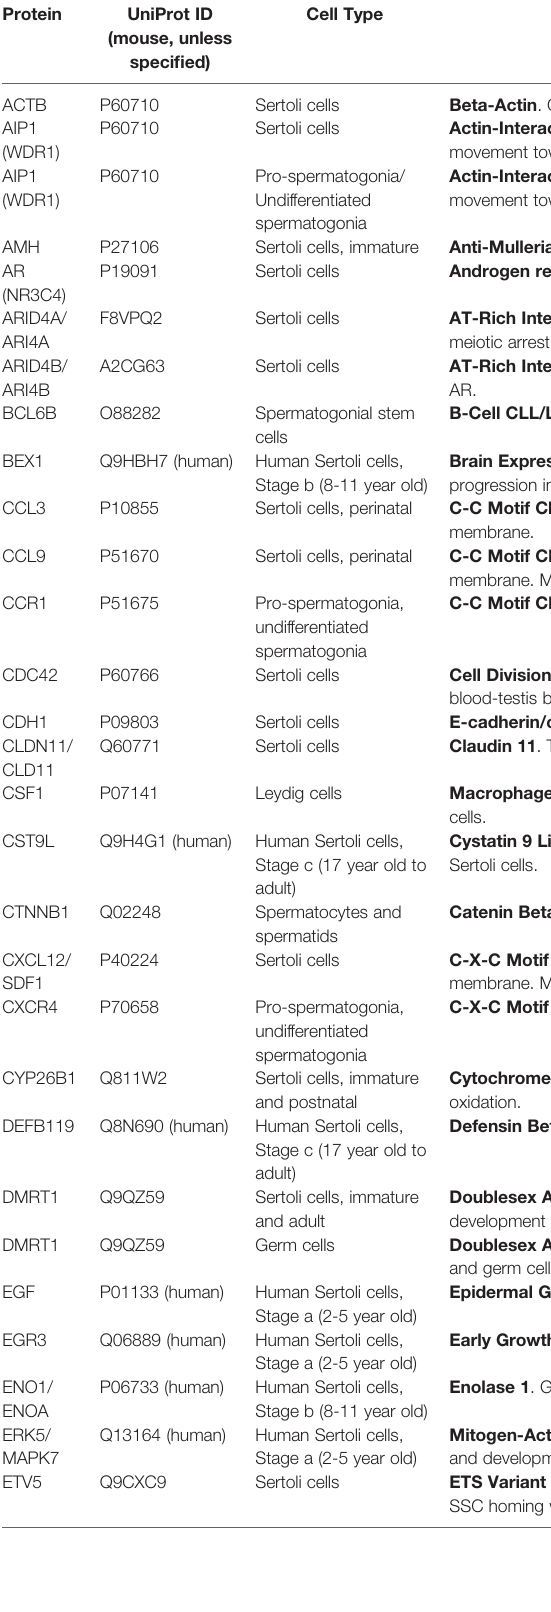
TABLE 1 | Names and functions of proteins discussed in this review. Protein UniProt ID (mouse,